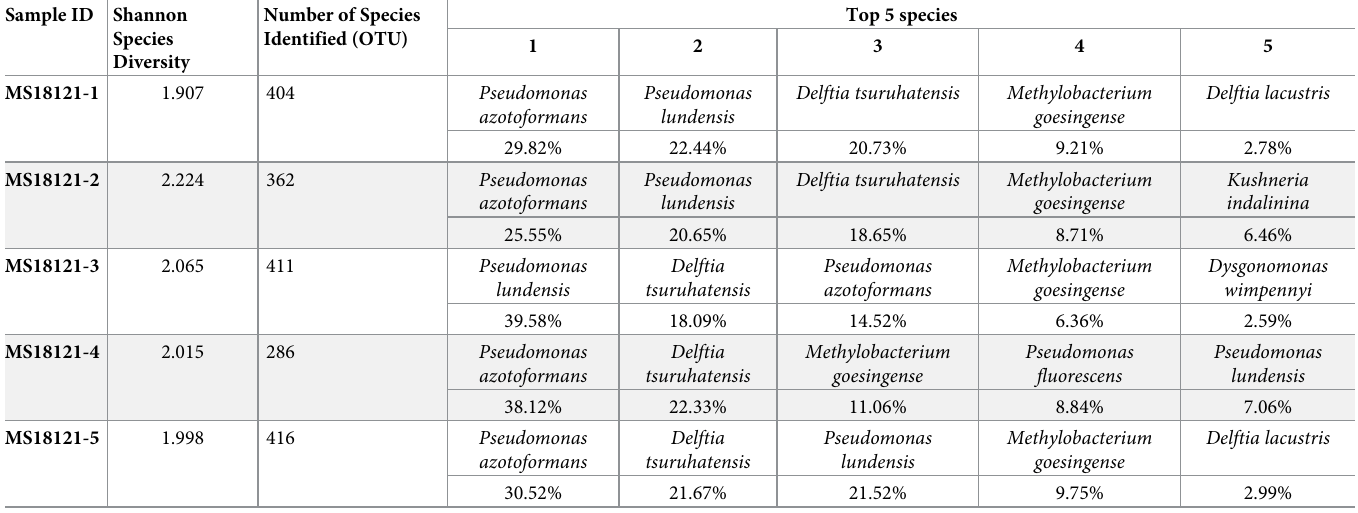
Table 3. Bacteria identified in the oropharynx of N . atra based on the 16S metagenomics